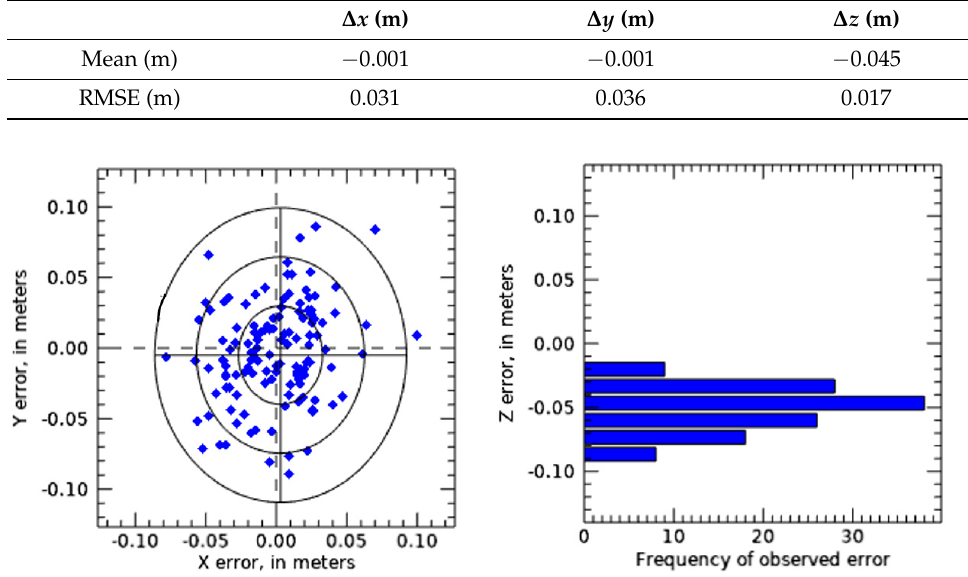
Figure 8. Horizontal ( left ) and vertical ( right ) accuracy assessment results using amorphous object method. jec